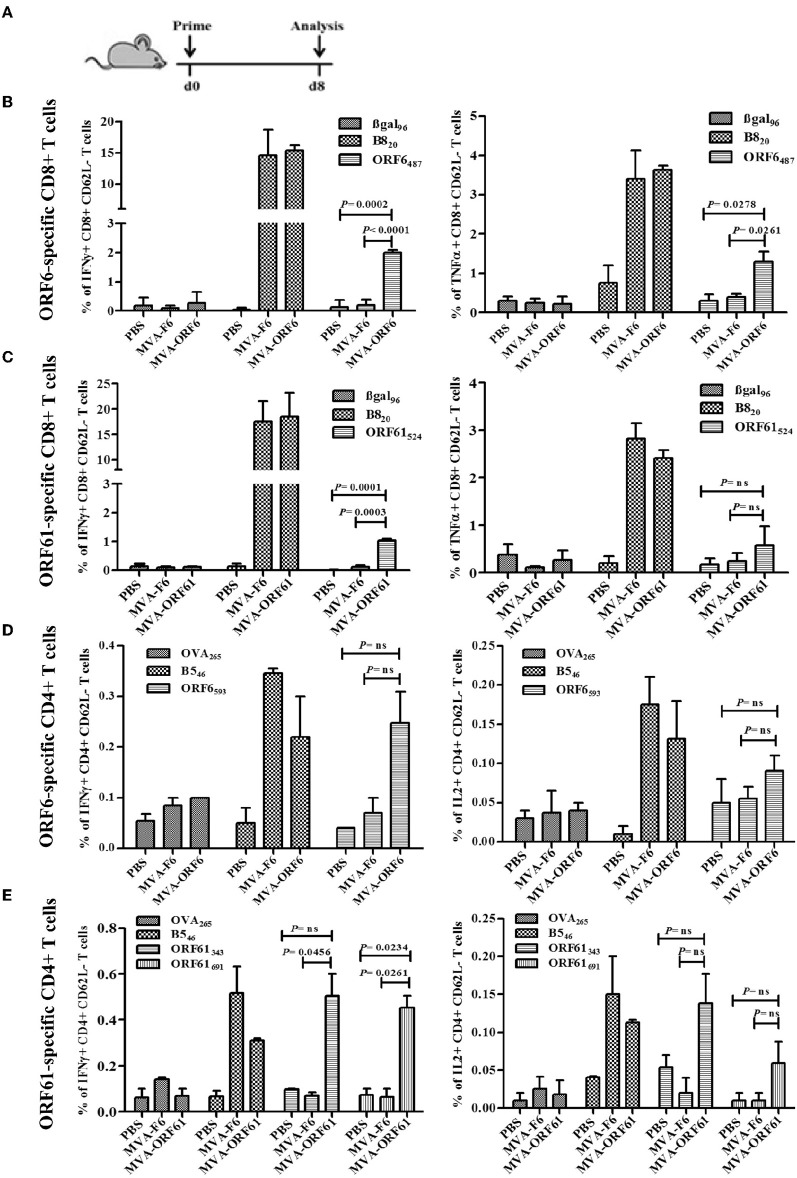
Primary CD8+ and CD4+ T cell response after recMVA vaccination. (A) C57BL/6 mice were vaccinated i.p. using 1 × 108 IU/200 μl of MVA-F6 (wildtype), MVA-ORF6 or MVA-ORF61 or 200 μl of PBS as a control group. For ex vivo T cell analysis (ICS followed by FACS) splenocytes were prepared from immunized mice at 8 dpi. (B,C) CD8+ T cell response. (B) Frequencies of activated (CD62L-) ORF6487- or (C) ORF61524 specific CD8+ T cells producing IFNγ (left panel) or TNFα (right panel). βgal96 or B820 peptides were used as unrelated or MVA-specific controls, respectively (D,E) CD4+ T cell response. (D) Frequencies of activated (CD62L-) ORF6593- or (E) ORF61343- and ORF61691-specific CD4+ T cells producing IFNγ (left panel) or IL2 (right panel). OVA265 or B546 peptides were used as unrelated or MVA-specific controls, respectively. Data shown are mean ± SEM of n = 6 mice per group, pooled from 3 (B,C) or two independent experiments (D,E).